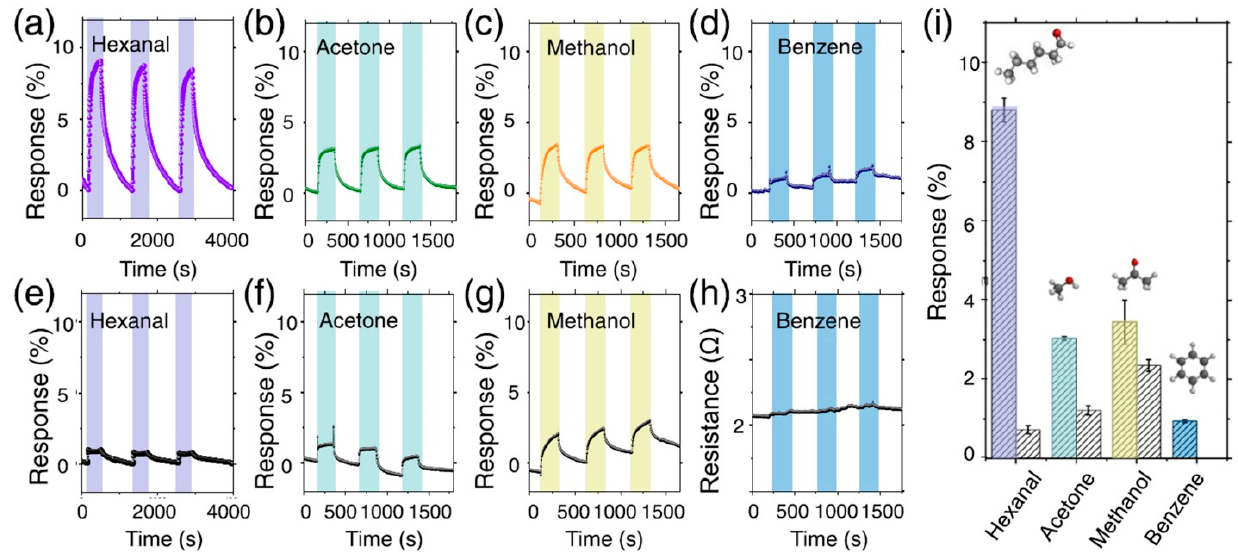
Figure 12. Normalized real-time responses of the Ti 3 C 2 T x -TiO 2 nanocomposites sensor to 100 ppm ( a ) Hexanal, ( b ) Acetone, ( c ) Methanol, and ( d ) Benzene in 3 successive cycles. Normalized real-time